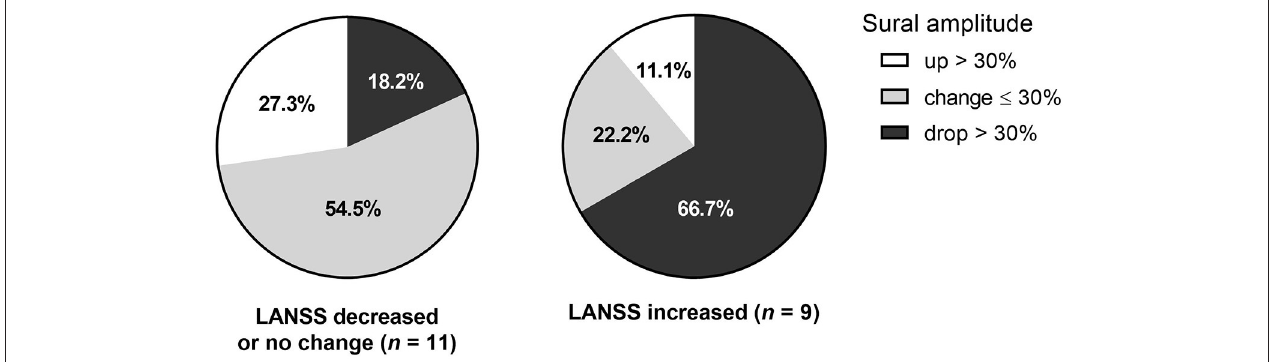
FIGURE 1 | Change of sural amplitude in relation to symptomatic change.The change of sural amplitude was associated with change of LANSS score. The LANSS score decrease, or no change was associated with follow-up sural amplitude change of less than or equal to 30% or over 30% increase. On the other hand, LANSS score increase or worsening of symptoms were most frequently observed in those with sural amplitude drop over